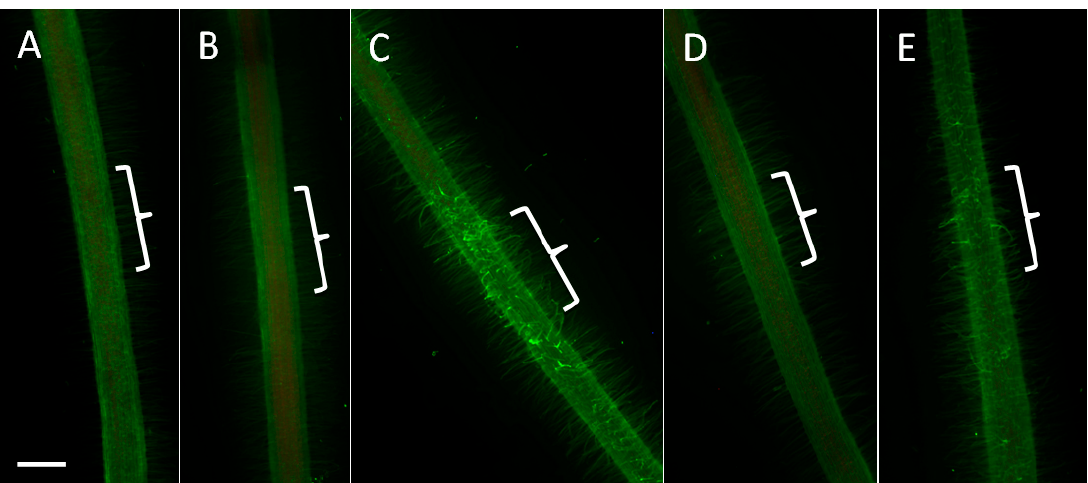
Figure 5. Induction of reactive oxygen species in response to nitrate and S. meliloti . Reactive oxygen species (ROS) were visualized at 24 h p.i. following spot inoculation of the root with S. meliloti (1021) (marked with a bracket). ( A ) Mock-inoculated root in the absence of nitrate; ( B ) Mock-inoculated root in the presence of 2.5 mM nitrate; ( C ) S. meliloti (1021)-inoculated root in the absence of nitrate. Note the strong induction of green fluorescence in root hairs indicating the presence of (ROS) (18/22 roots); ( D , E ) S. meliloti (1021)-inoculated root in the presence of 2.5 mM nitrate. The lack of response in D was found in 22/28 roots, the weak response in E was found in 6/28 roots. Magnification bar represents 1 mm.